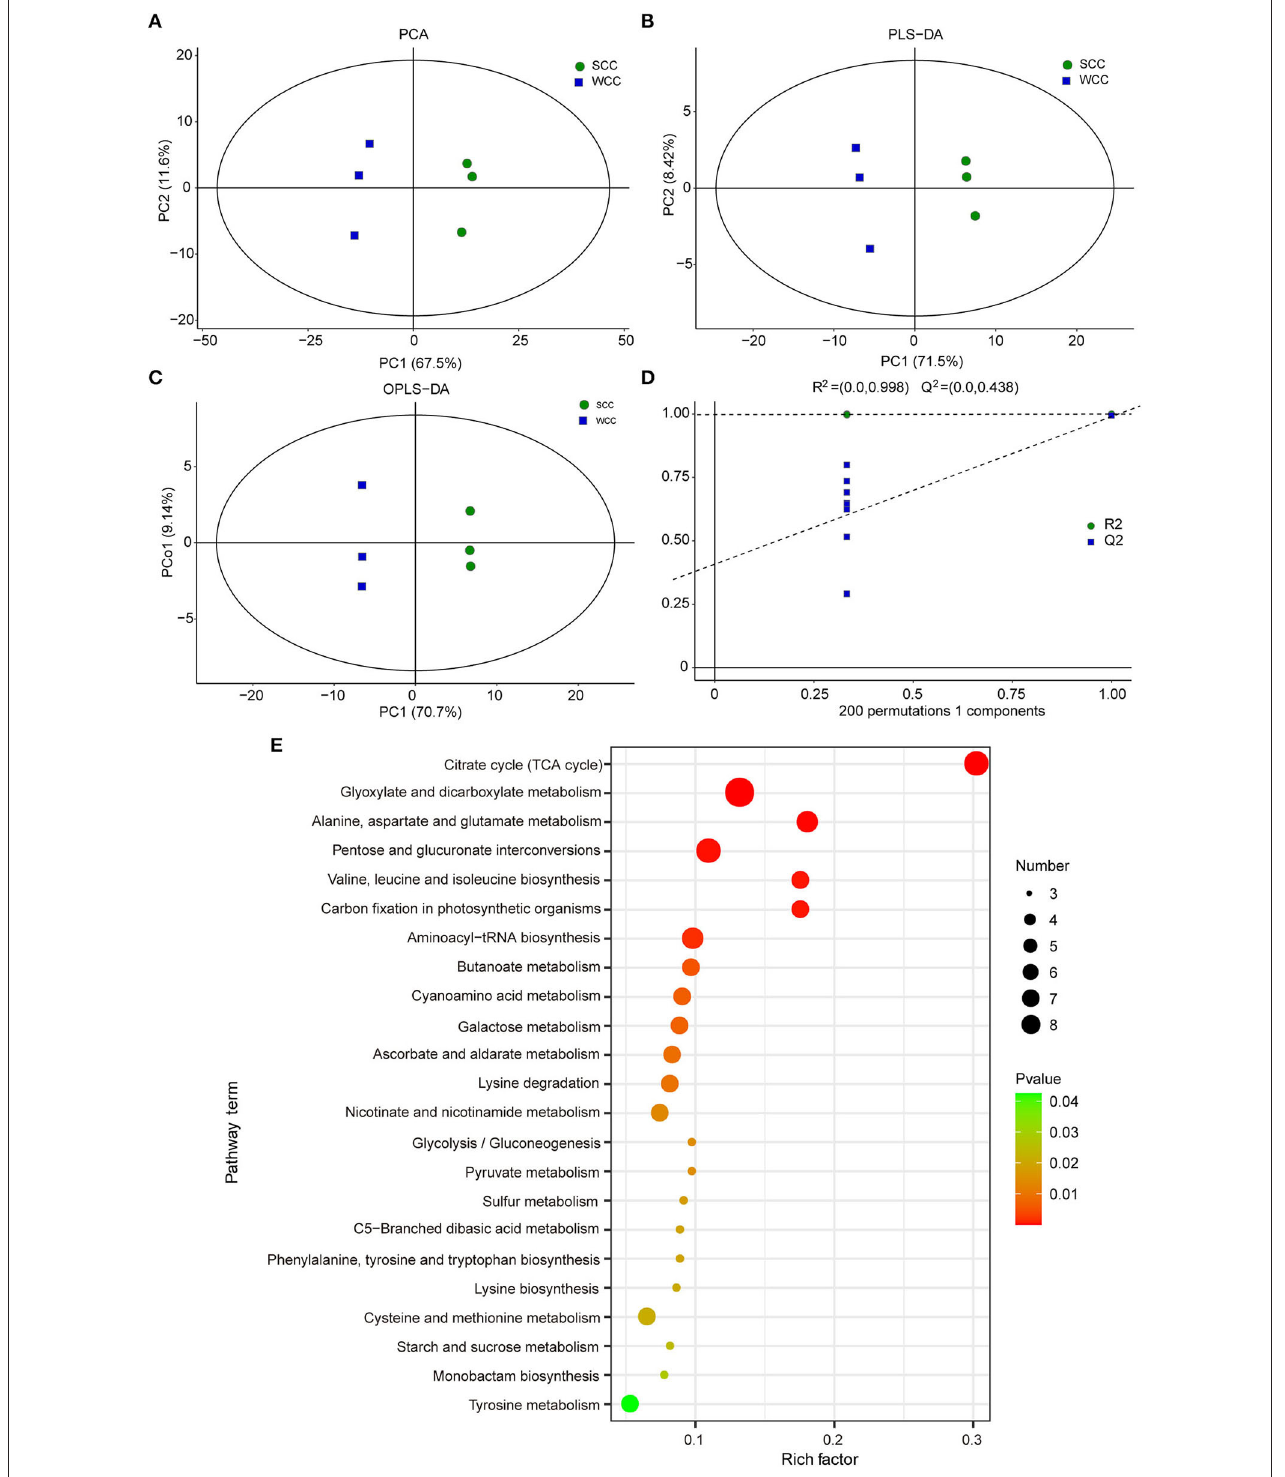
FIGURE 2 | Multivariate statistical analysis of the differentially synthesized metabolites (DSMs) based on gas chromatography–mass spectrometry (GC-MS). (A) Plots of principal component analysis (PCA); (B) partial least squares discriminant analysis (PLS-DA); and (C) orthogonal PLS-DA (OPLS-DA). The x - and y -axes represent the first (PC1) and second (PC2)/orthogonal (PCo1) principal components, respectively; SCC and WCC represent summer and winter C. fortunei needles, respectively. (D) The 200-response sorting tests of the OPLS-DA model. (E) KEGG analysis of DSMs. The x - and y -axes represent the enrichment factor and pathway term, respectively. The colors and sizes of the dots represent the significance ( p ) and number of metabolites, respectively.